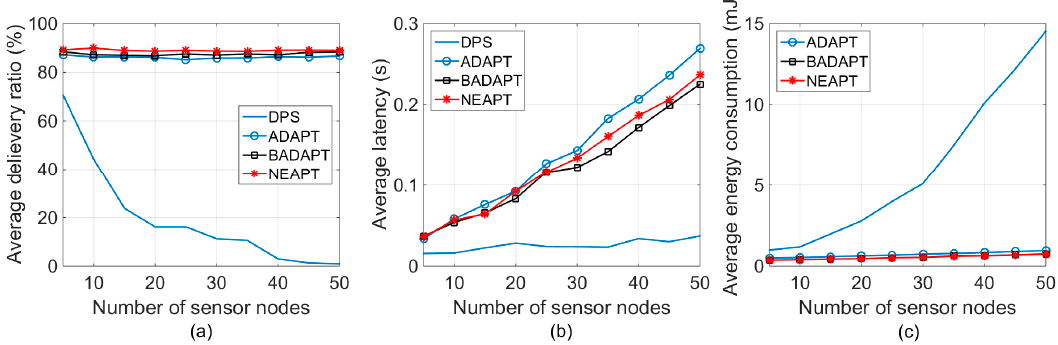
Figure 3. Delivery ratio, latency and energy consumption under stationary conditions. ( a ) Average delivery ratio. ( b ) Average latency. ( c ) Average energy consumption. delivery ratio. ( b ) Average latency. ( c ) Average energy